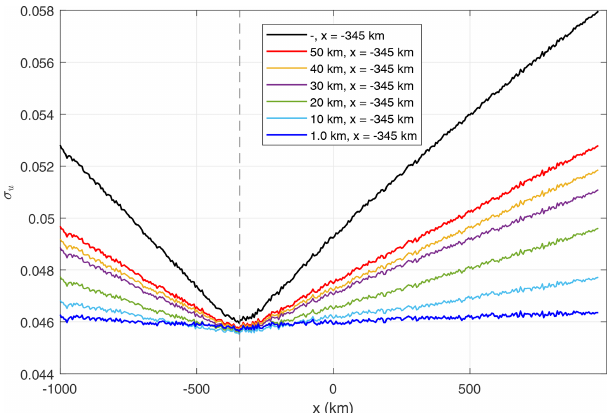
Figure 9. BP amplitude standard deviation in scenarios assuming different vertical extensions of a single bubble in the inbound re- gion and assuming σ (cid:49)ρ/ρ = 17%. The dashed black curve corre- sponds to the reference case. The location estimate is possible up to the thinnest layer, resembling the sporadic E-layer dimension. Estimation error σ x = − 1 . 7km. Vertical dashed lines indicate the placement of the irregularity